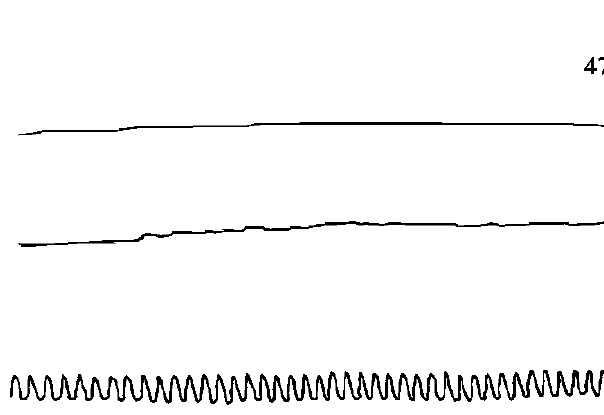
mmmmmwmmummm^M Figure 2b Example of post-intervention laryngographic tracing during reading ings. A distinguishing feature of these tracings is the relatively flat base which suggests a long open phase of the vocal folds. Figures